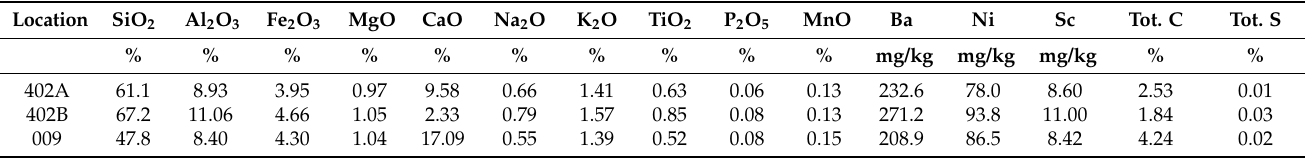
Table 4. The average content of major elements in older (402A) and younger (402B)